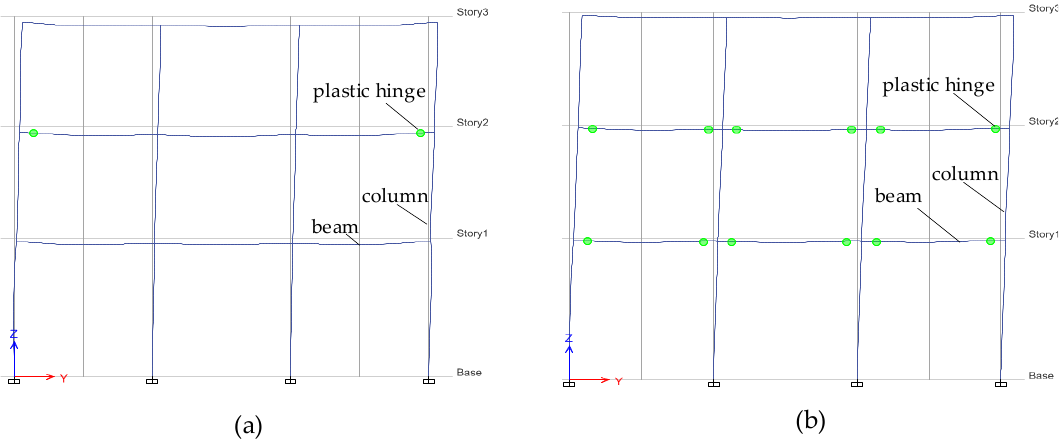
Figure 11. Deformation shape of model F3-LB3.33: ( a ) rigid diaphragm model; ( b ) flexible diaphragm model.